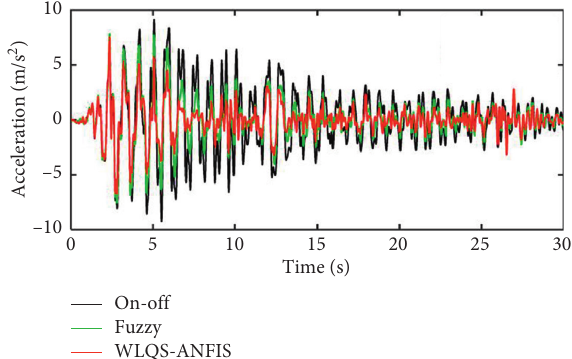
Figure 19: The top floor acceleration responses with different control methods.